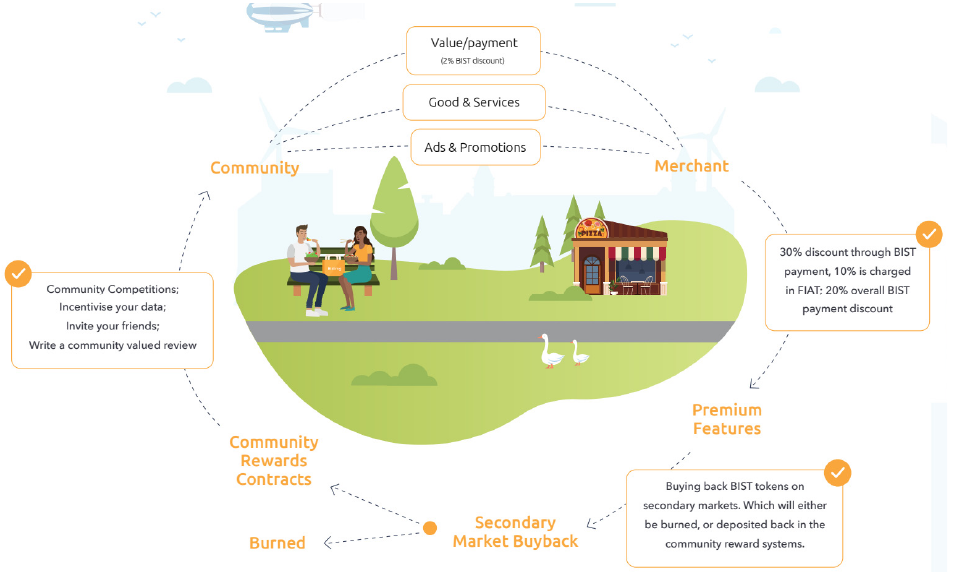
Figure 4. Bistroo Blockchain Operation Process.